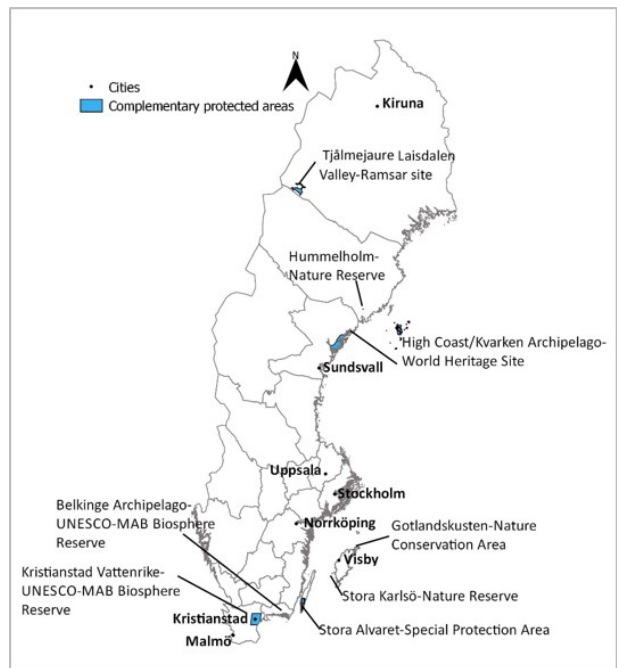
Figure 4. The eight protected areas needed to conserve 101 priority CWR